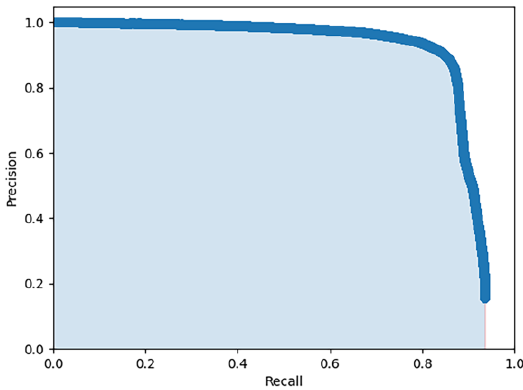
Figure 5. The PR curve.